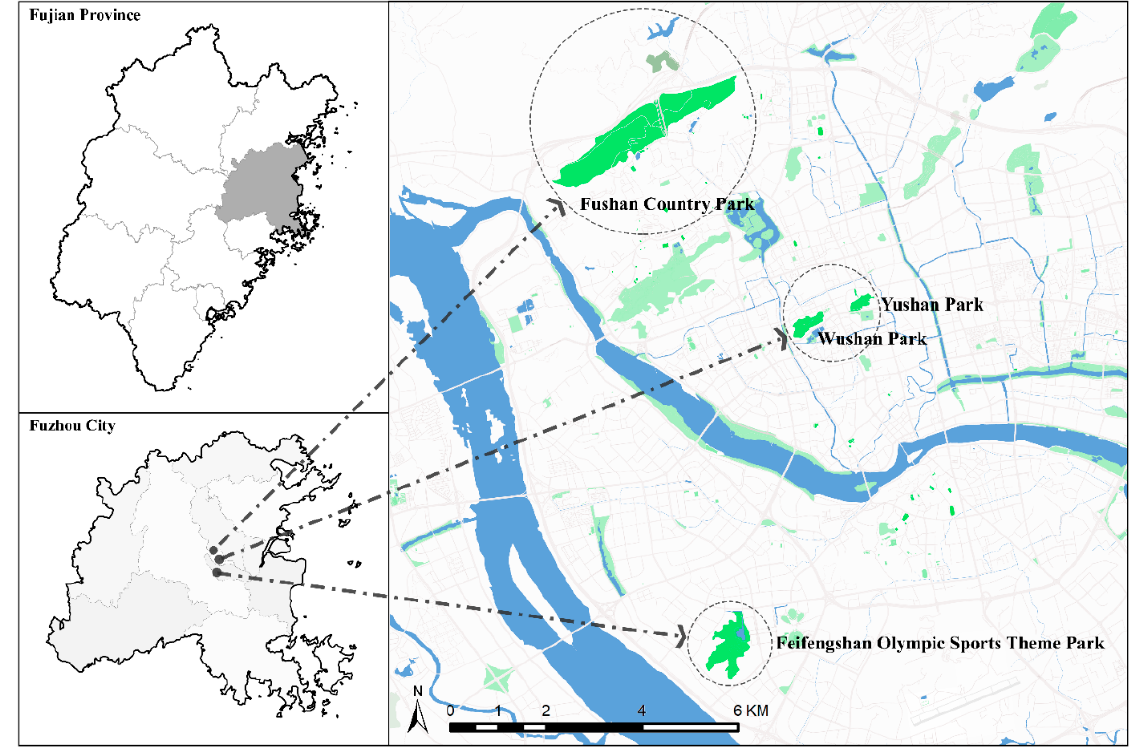
Figure 1. Map of the study area shows the location of the study sites adapted from Google Earth.